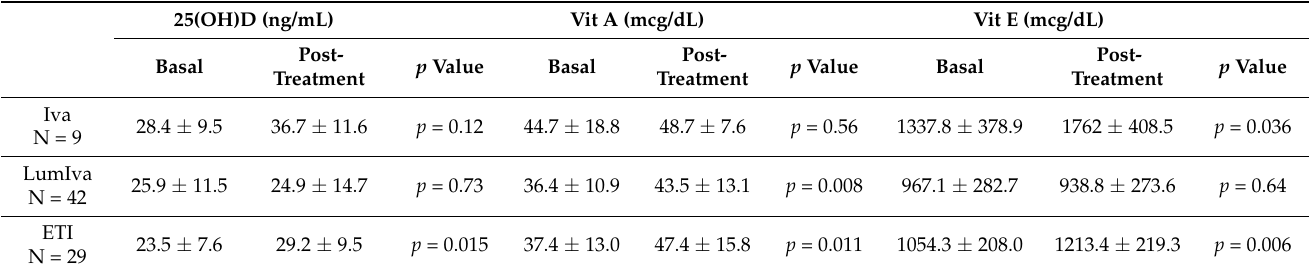
Figure 3. BMI trend (mean ± SD) in 30 female patients aged ≥ 18 years treated with modulators (IVA N = 5, LumIva N = 13 and ETI N = 12).